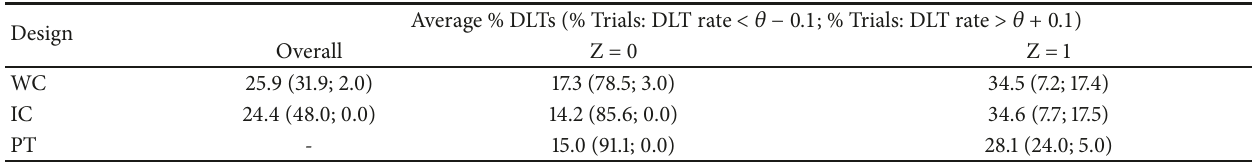
Table 3: Operating characteristicssummarizing trial safety for designs using a covariate (WC), ignoring the covariate (IC), and parallel trials (PT) considering discrete dose combinations.